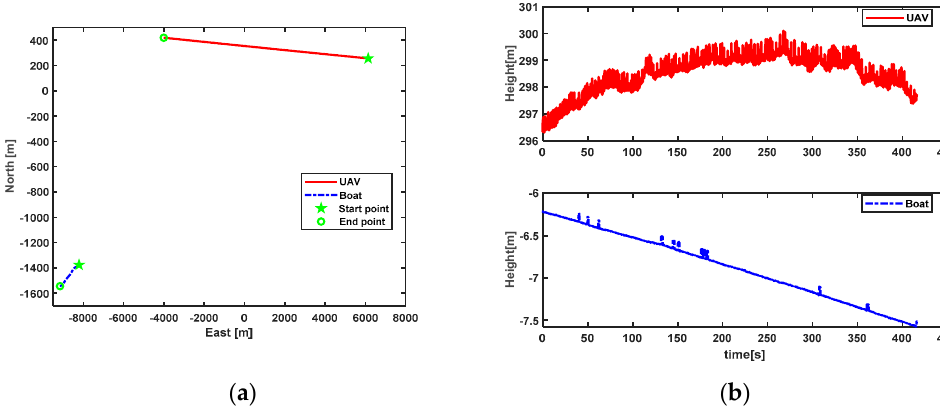
Figure 11. Trajectories of the UAV and boat in test 2. ( a ) Horizontal direction; ( b ) vertical direction.